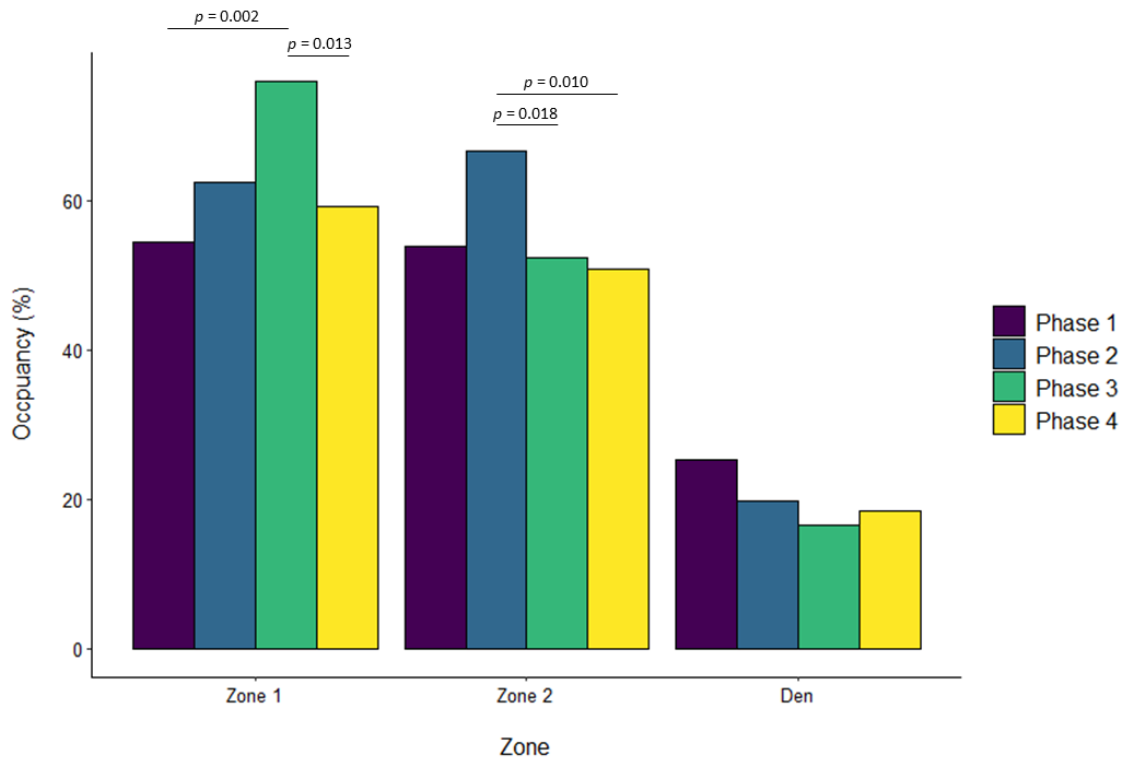
Figure 7. Percent occupancy of each zone by phase for the grizzly bears. Means and standard deviations for fecal glucocorticoid levels by phase for each species are presented in Table 5. Pairwise comparisons of fecal glucocorticoid levels between phases and associations with temperature and day of the week for the grizzly bears are presented in Table 7 and Figure 8. There were no significant differences in glucocorticoid levels between phases for either grizzly bear. Temperature was significantly associated with fecal glucocorticoid levels in the female grizzly bear but not the male. Fecal glucocorticoids did not significantly vary between weekdays and weekends for either grizzly bear. Table 7. Pairwise comparisons of glucocorticoids by phase as well as associations with temperature and day of the week (weekday vs. weekend) for each grizzly bear.